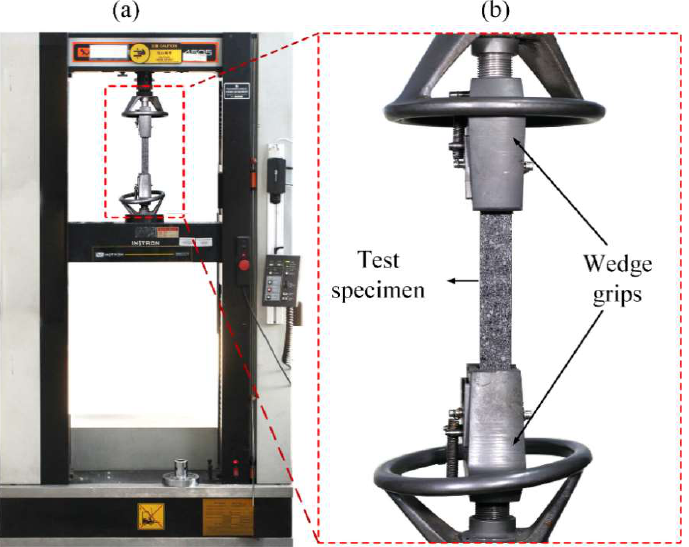
Figure 3. Photograph of tensile testing configuration ( a ) Instron testing machine ( b ) Tensile test specimen.